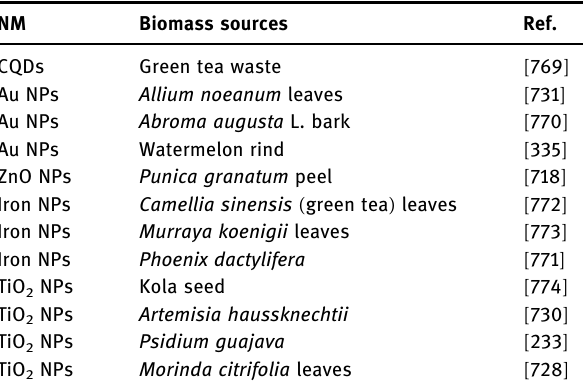
Table 16: Application of recycled NPs as